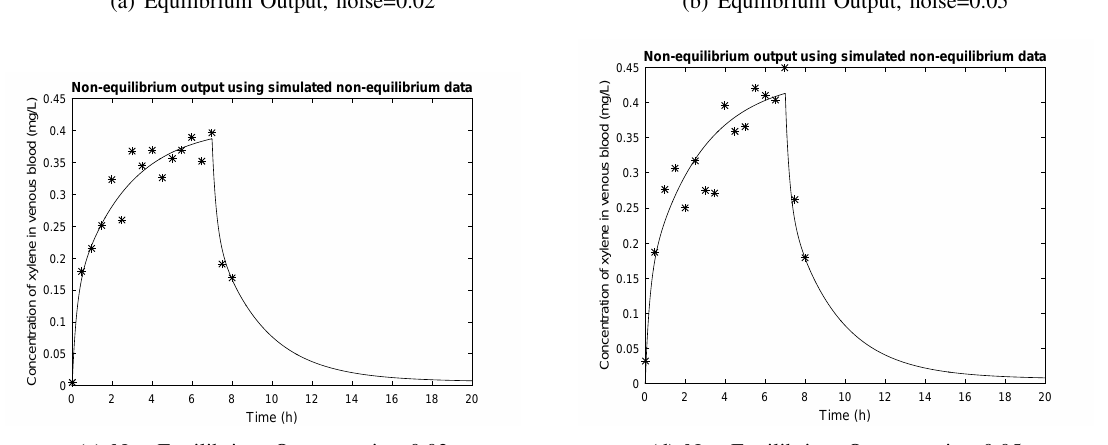
(d) Non-Equilibrium Output, noise=0.05 Fig. 9. Model output for the concentration of xylene in venous blood after optimization over data simulated from the non-equilibrium model with given noise level and V xyl maxc = 6 . Figures (a)-(b) contain equilibrium model output and Figures (c)-(d) contain non-equilibrium model output.